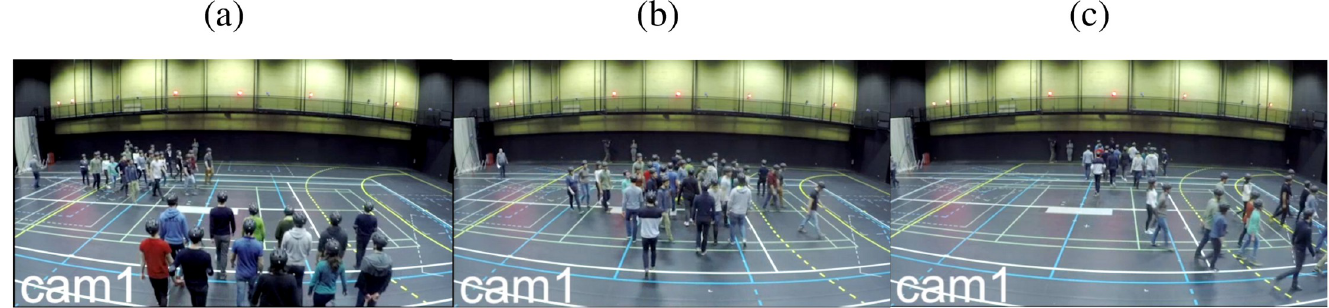
Fig 1. Photograph of our experimental set-up to study crossing flows. Agents participating in our experiment are shown in this photograph for a typical trial with crossing angle 120˚. The three stages of the trial are shown here, viz. (a) before crossing (b) during crossing and (c) after crossing.